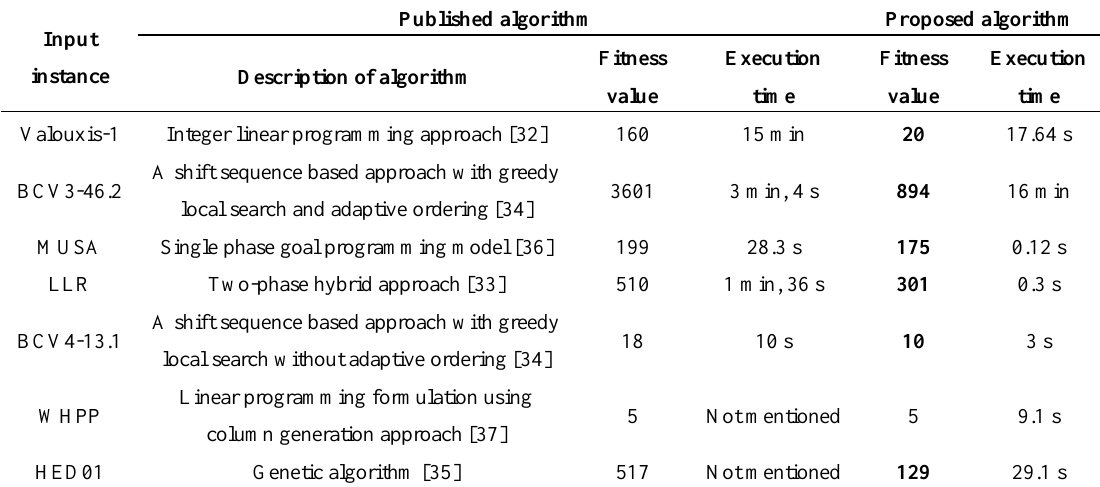
Table 2. Comparing the best timetables constructed by the proposed algorithm with the best timetables created in